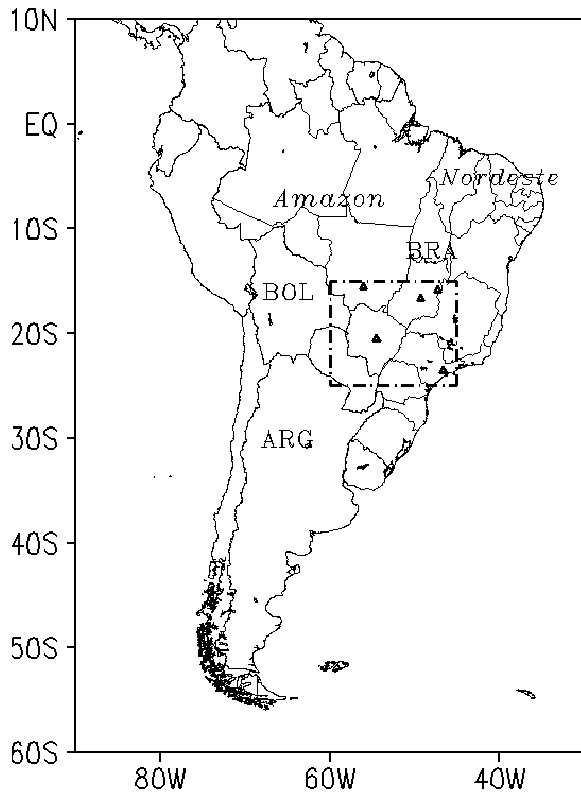
Fig. 1. Locator map. BRA: Brazil, ARG: Argentina, BOL: Bo- Fig. 1 – Locator map. BRA: Brazil, ARG: Argentina, BOL: Bolivia. The Amazon livia. The Amazon ( Amazon ) and Northeast Brazil ( Nordeste ) are ( Amazon ) and Northeast Brazil ( Nordeste ) are indicated. The rectangle is the target area. indicated. The rectangle is the target area. Deltas mark the 5 ma- Dark triangles mark the 5 major cities where the surface temperature observations are jor cities where the surface temperature observations are compared with the NCEP/NCAR data. compared with the NCEP/NCAR data.